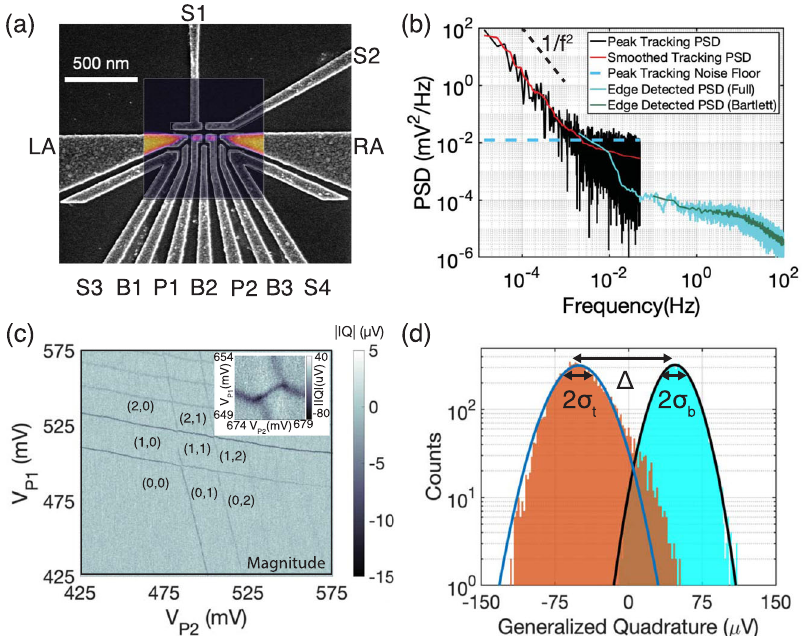
Fig. 3 Evaluation of charge noise and readout SNR in a 3D integrated DQD. a An SEM of the single-layer double quantum dot (DQD) aluminum gate structure with the resonator connected to S1. Overlaid is a Thomas-Fermi simulation of a DQD in the few electron regime. b DC transport, gate referred noise measurements in the device. The black trace is acquired using a peak location monitoring method over a 21 h period (red is smoothed using a moving mean). The teal and green traces are extracted by measuring current fl uctuations at the maximum fi rst derivative point of a Coulomb blockade peak for 510 s. c Dispersive gate charge sensing of a double quantum dot formed under P1 and P2 down to single electron occupancy using the high-impedance TiN resonator as a dispersive gate readout. Inset: A tunnel coupled many electron double quantum dot with n L , R ≈ 10. d Generalized quadrature histogram showing the visibility of tunneling resonance (orange) vs blockade (teal). Here, a the drive power is ~ − 95 dBm on chip and yields an SNR ≈ 5.36. Solid lines are Gaussian fi ts to the